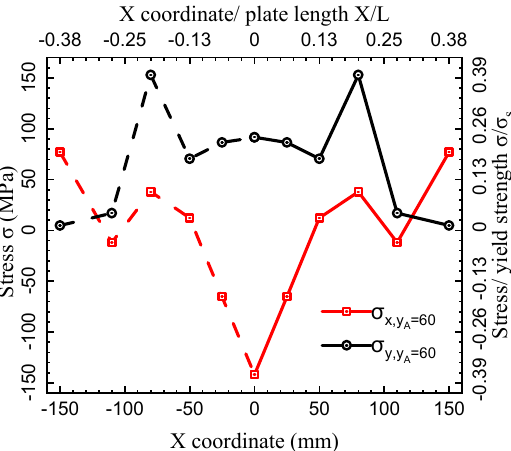
. Figure 19. (cid:3250) (cid:2880)(cid:2874)(cid:2868)